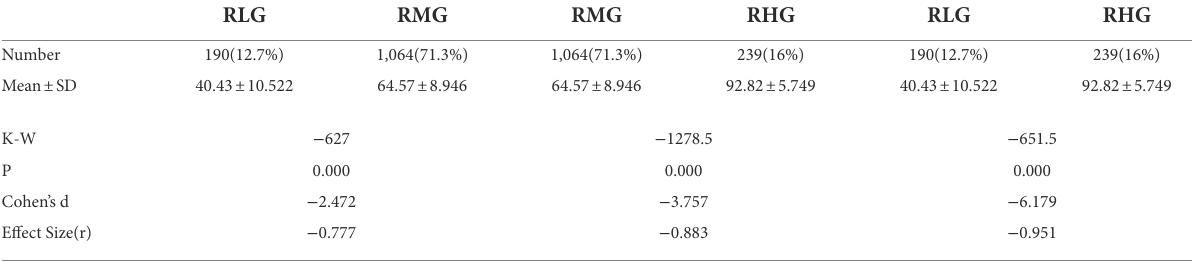
TABLE 1 Comparison of the resilience scores of RHG, RMG, and RLG (Mean ± SD).